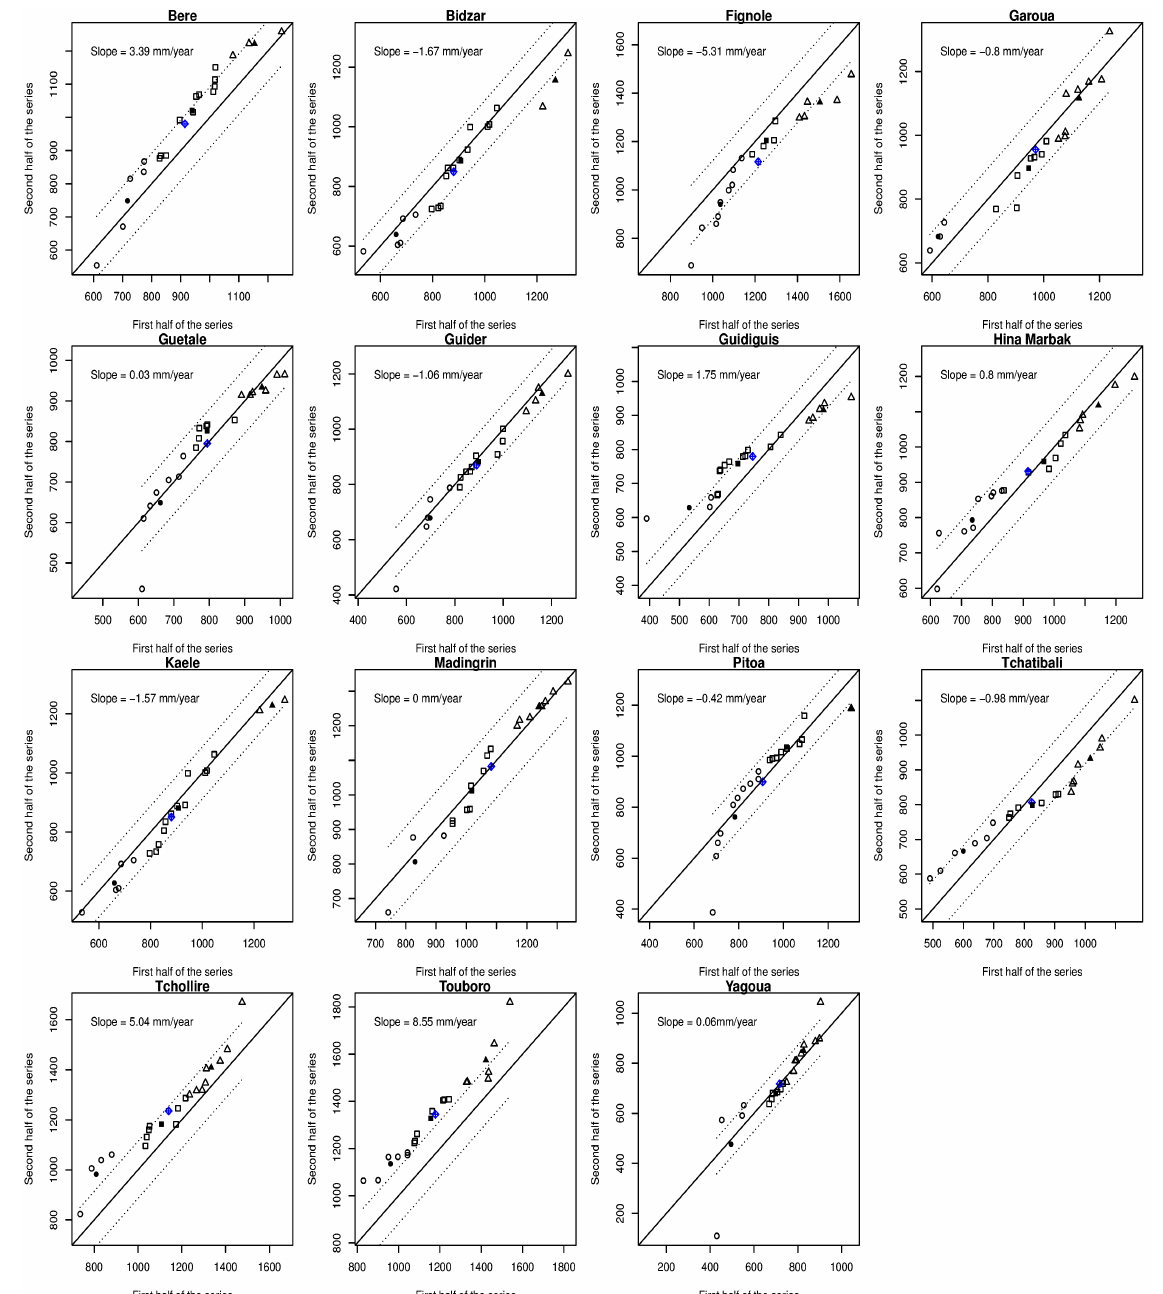
Figure 4. Innovative trend plots for PRCPTOT. The blue diamond symbols indicate monotonic trends over the whole record period, while the gray-filled circle, square, and triangle symbols are mean points of low-, medium-, and high-value clusters, respectively, used for identifying corre- sponding sub-trends. All random symbols in the upper/lower triangular areas indicate increas- ing/decreasing trends, while the 1:1 (45°) straight line corresponds to trend-free cases.